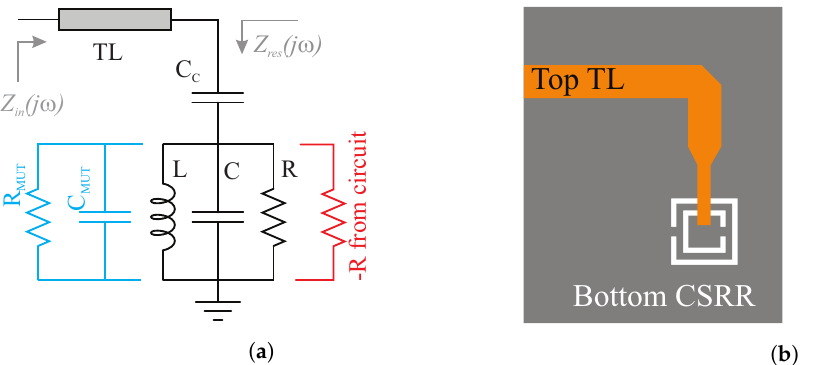
Figure 3. ( a ) Circuit model with extracted parameters as L = 0.59 nH, C = 1.037 pF, C C = 0.18 pF, and R = 1.47 k Ω . ( b ) CSRR